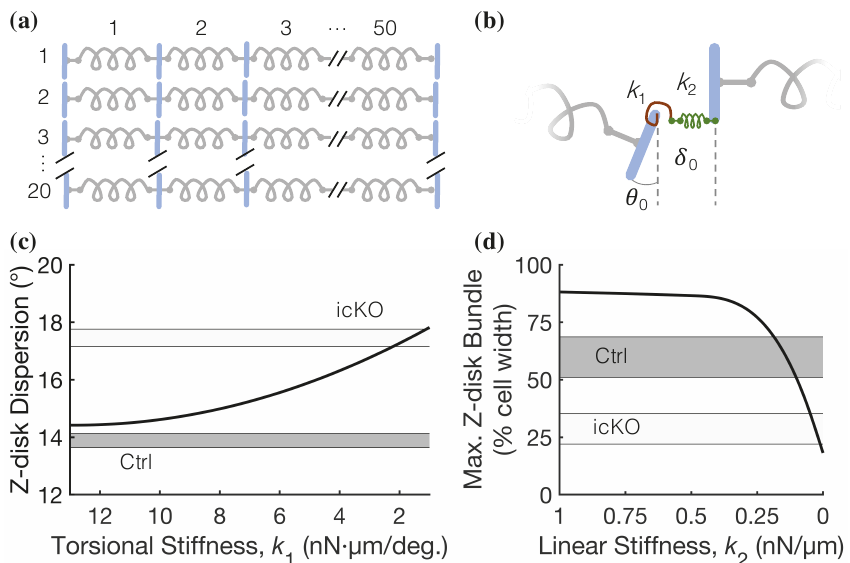
Figure 6. Cell-level model of the effects of spatial organization and inter-myofibril connectivity of sarcomeres on cell mechanics. ( a ) Schematic of our new spatially explicit computational model of a cardiomyocyte with 1000 sarcomeres (gray springs). ( b ) Adjacent Z-disks (blue) are mechanically coupled by a torsional (red) and a linear (green) spring system with stiffness k 1 and k 2 , respectively. ( c ) The model predicts that the stiffness of the torsional spring ( k 1 ) regulating the orientation of the Z-disk must decrease by ~1 order of magnitude to account for the increase in Z-disk angular dispersion (Figure 3h) in icKO cardiomyocytes compared with control cardiomyocytes (gray and black dashed lines, respectively). ( d ) When decreasing the stiffness of the linear spring ( k 2 ) and regulating the distance ( δ 0 ) between adjacent Z-disks from 1–0 nN/ µ m, the model predicts that the maximum Z-disk bundle (as a % of cell width) decreases from above the value measured for control cardiomyocytes (black dashed line) to below that of icKO cardiomyocytes (gray dashed